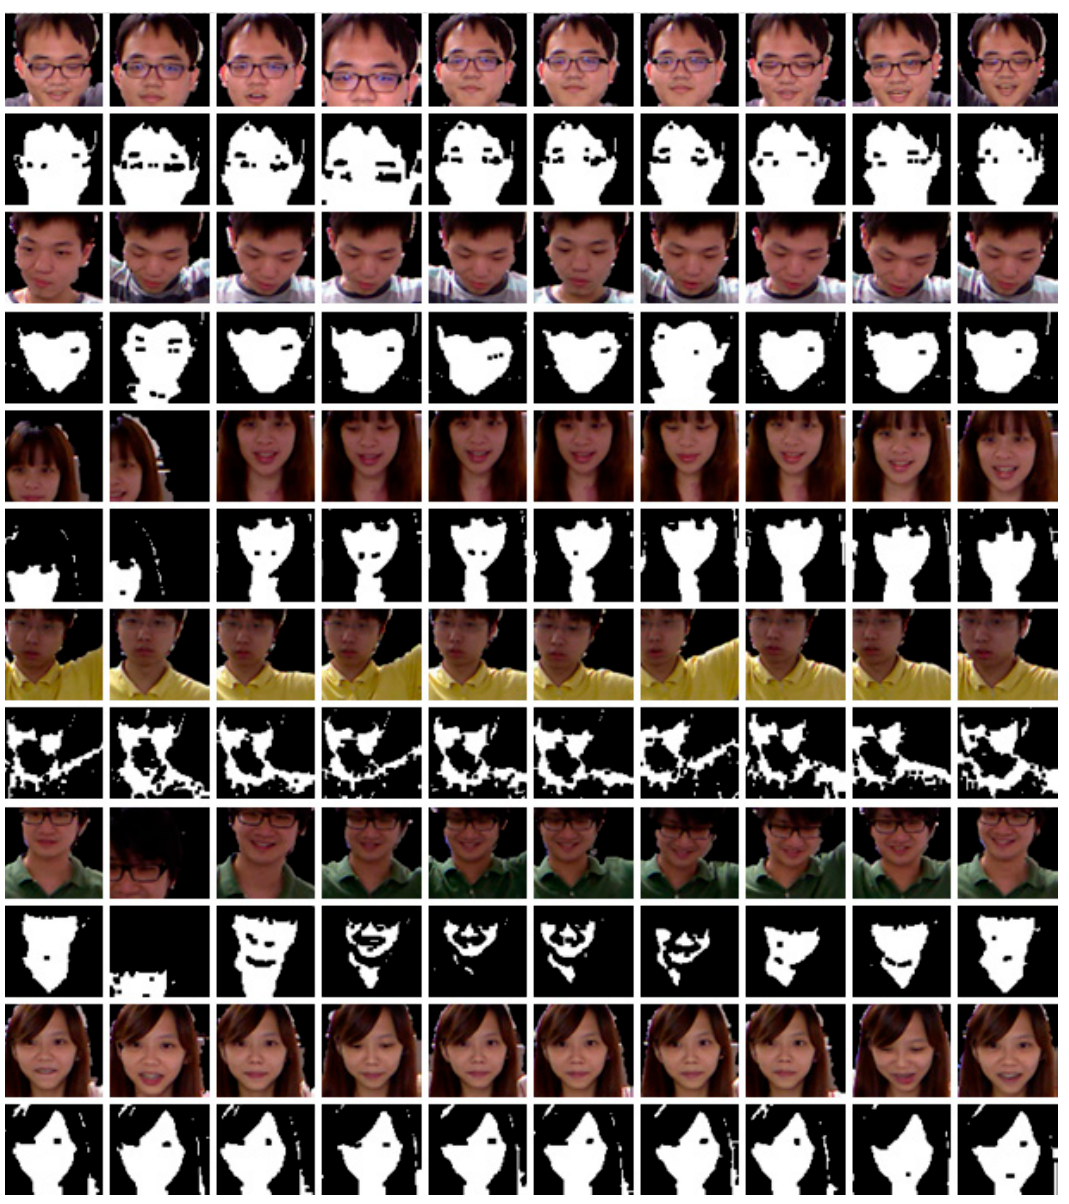
Figure 17. Results of test samples 15–20.